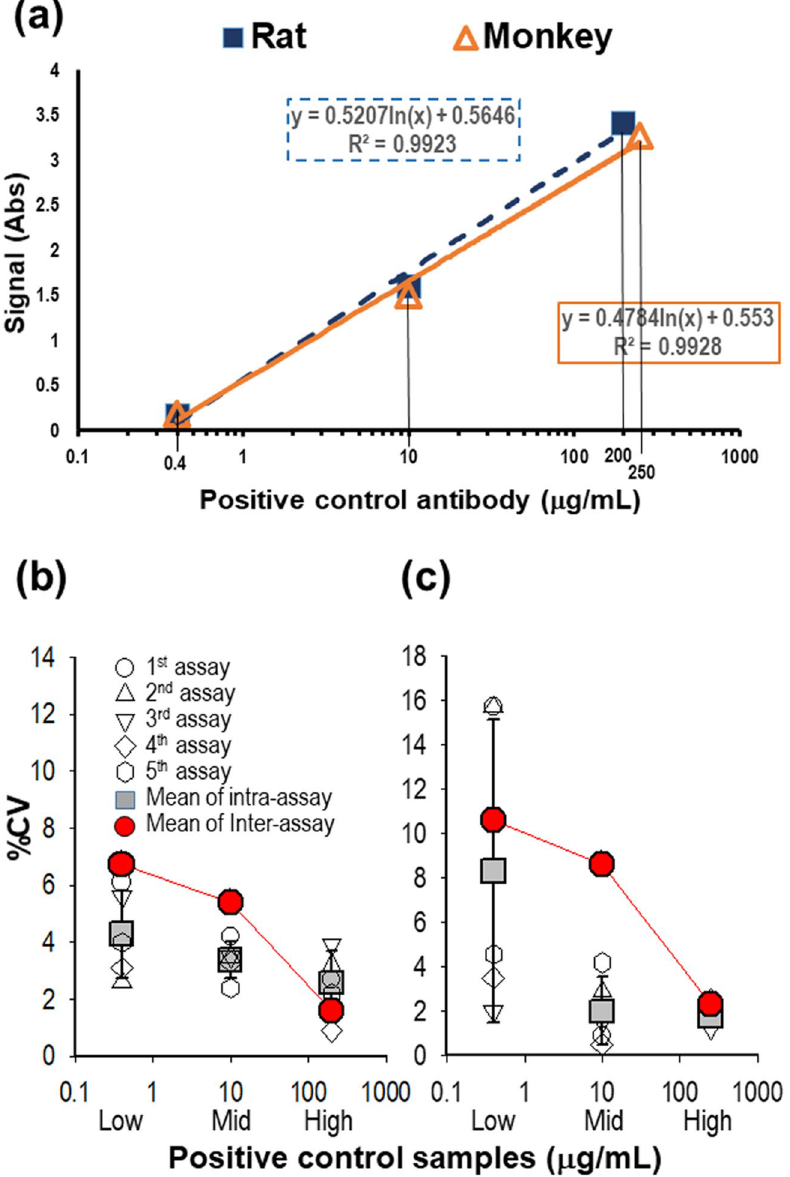
Figure 2. Evaluation of assay precision. Intra- and inter-assay variability were estimated using the %CV in 5 independent assays. ( a ) Representative high, middle, and low concentrations of the positive control antibody were selected in the linear range of a sigmoid curve for each set of serum samples. ( b ) High (200 μg/mL), middle (10 μg/mL), and low (0.4 μg/mL) concentrations of positive control samples (PC) in rat sera were measured for assay precision. ( c ) High (250 μg/mL), middle (10 μg/mL), and low (0.4 μg/mL) concentrations of PC in monkey sera were measured for assay